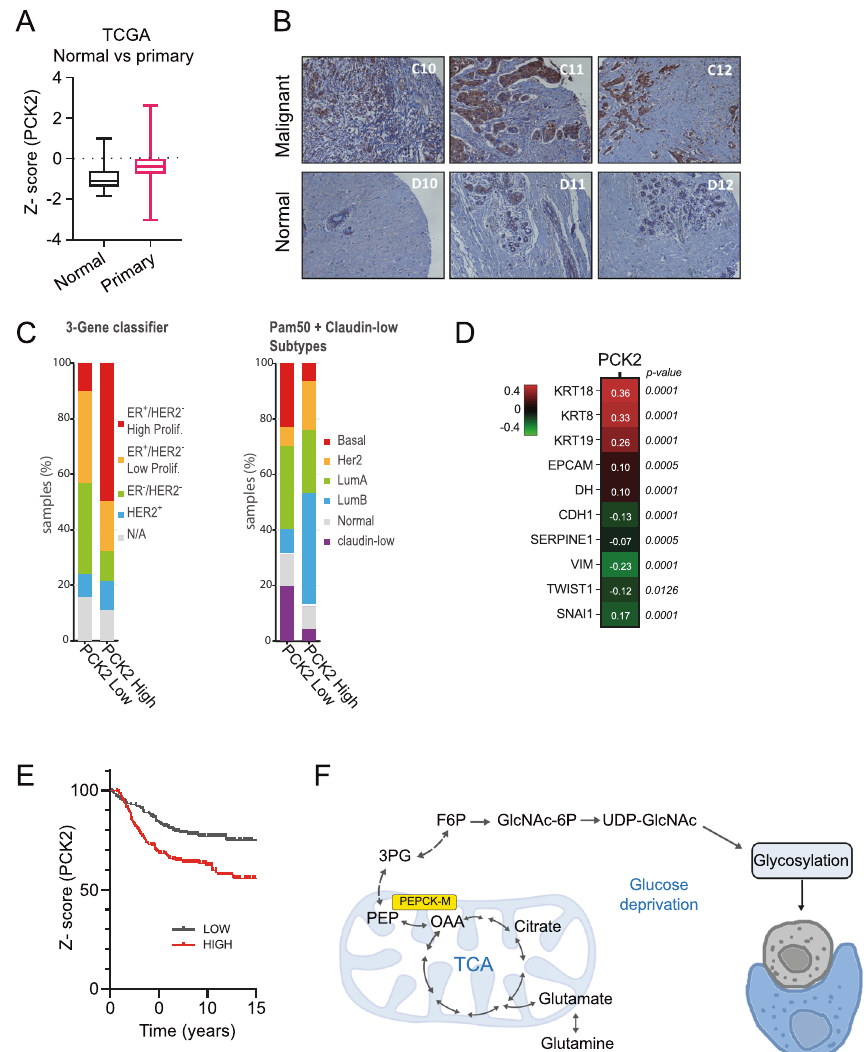
Fig. 5 PCK2 coexpresses with breast tumor carcinoma epithelial markers; implications for a role of entosis and PEPCK-M pathway in tumor growth and cancer survival. A PCK2 transcript expression on Agilent Gene Chip data obtained from “ Normal ” (GTEX database) breast tissue and Primary tumors from Yau 2010 study comprising clinical, Agilent Gene Chip gene expression data from datasets GSE2034, GSE5327, GSE7390 and NKI295, TPM units, Agilent normalized gene expression Z-score. Welch ’ s corrected t -test using Xena from UCSC Welch ’ s t -test ( p = 2.370E-8; t = − 6.234). B PEPCK-M protein content was probed on a tumor microarray panel containing normal and breast carcinoma sections, using a primary antibody against PEPCK-M and developed using DAB peroxidase. C PCK2 mRNA expression data from the